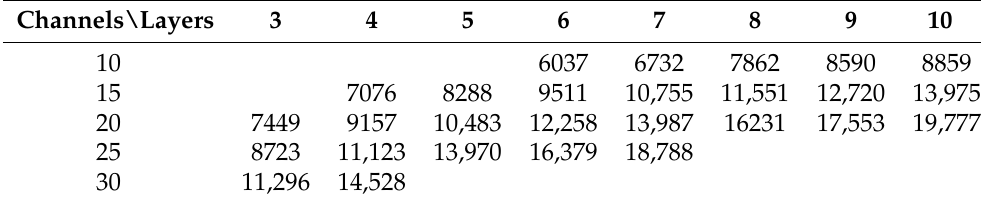
Table 7. Flip-flop estimation charts.